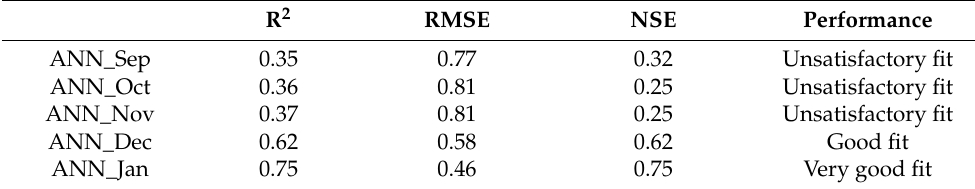
Table 7. ANN model performances during the validation